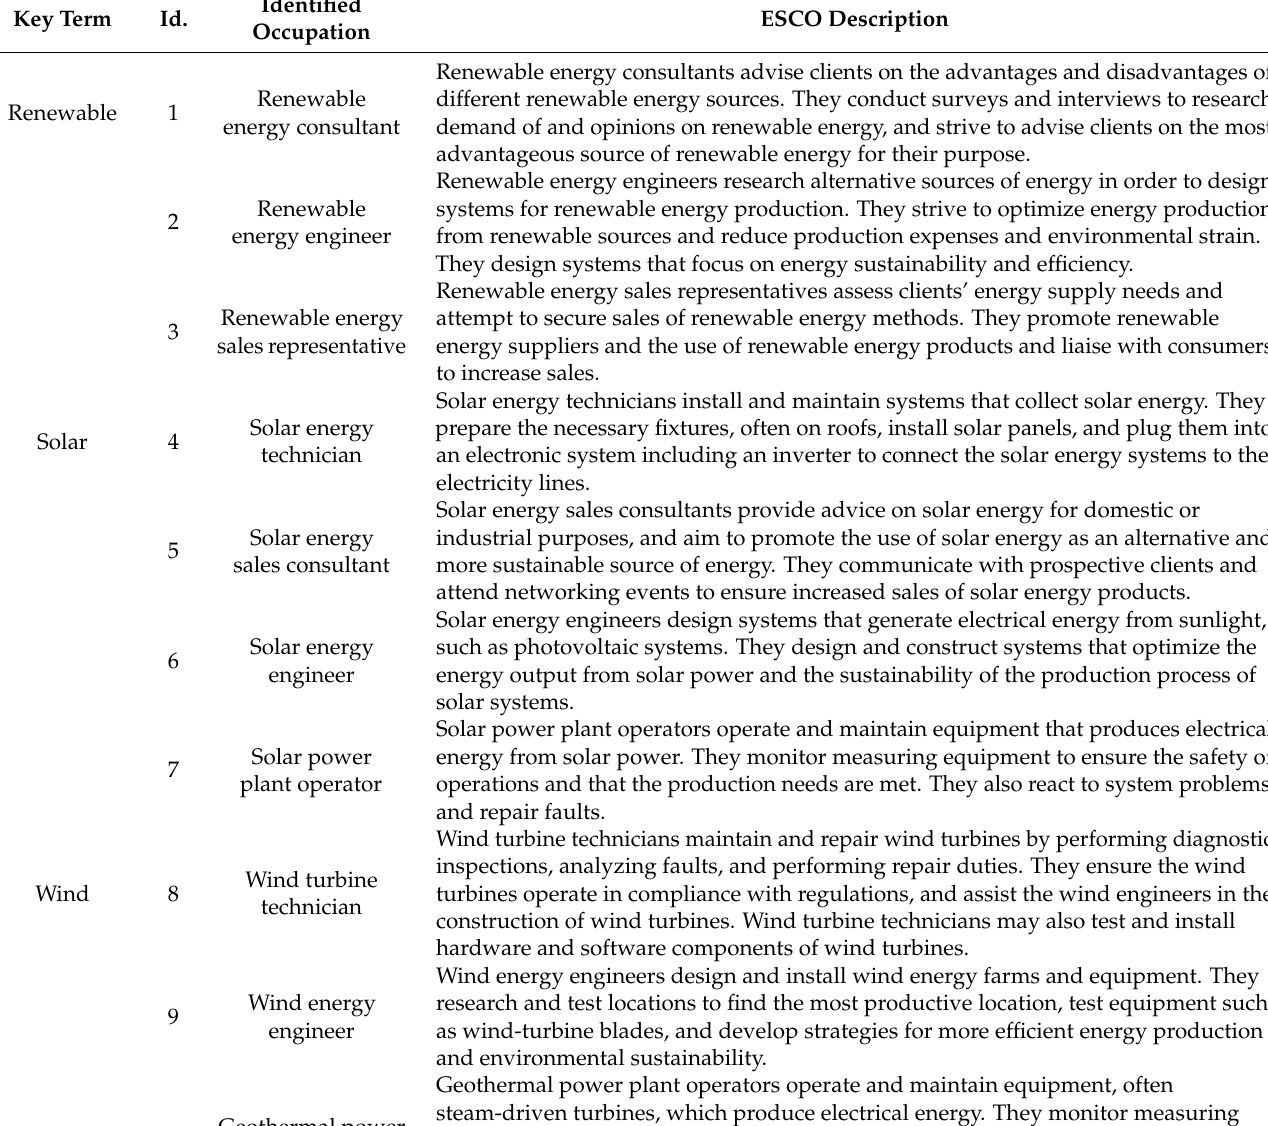
Table 1. The key terms related to “renewable energy” and 19 ESCO occupations identified after the